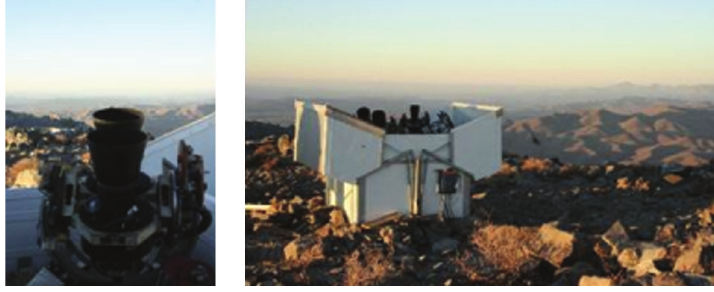
Figure 3: “Pi of the Sky” prototype located in the ASAS dome, Las Campanas Observatory,